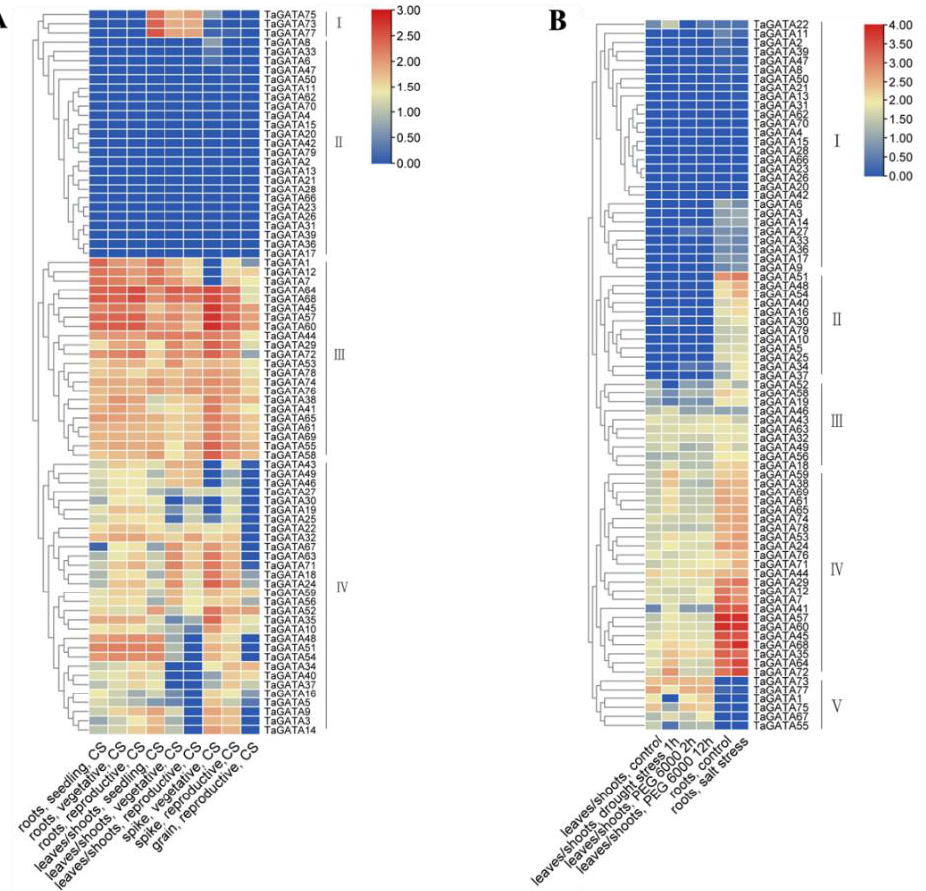
Figure 6. Transcriptional expression analysis of TaGATA genes by RNA-seq. ( A ) Expression profiling of TaGATA genes in different organs. ( B ) Expression profiling of TaGATA genes under abiotic stresses.